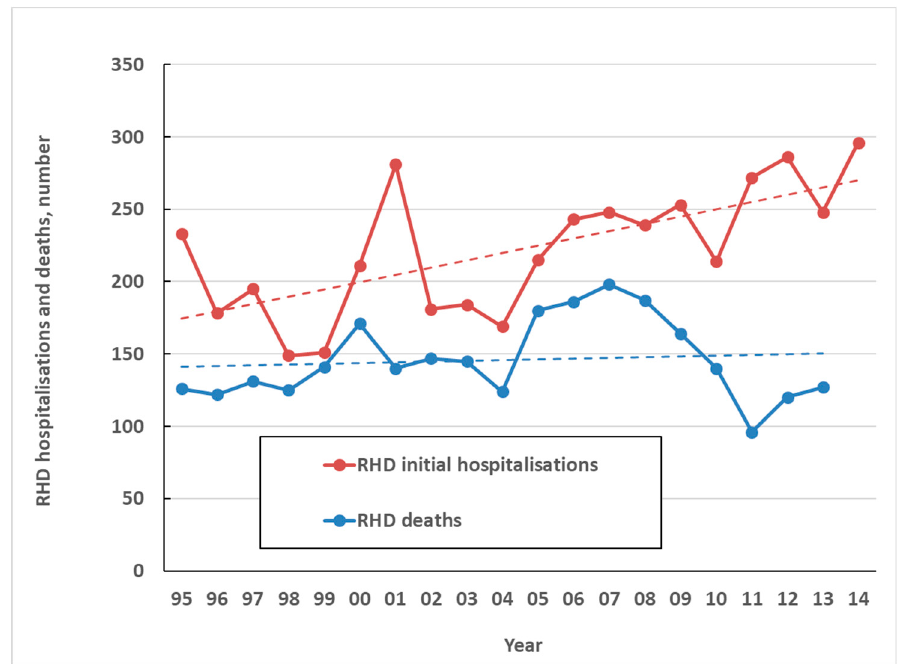
Figure 7. Coded RHD initial hospitalisations and deaths by year, 1995 to 2014.